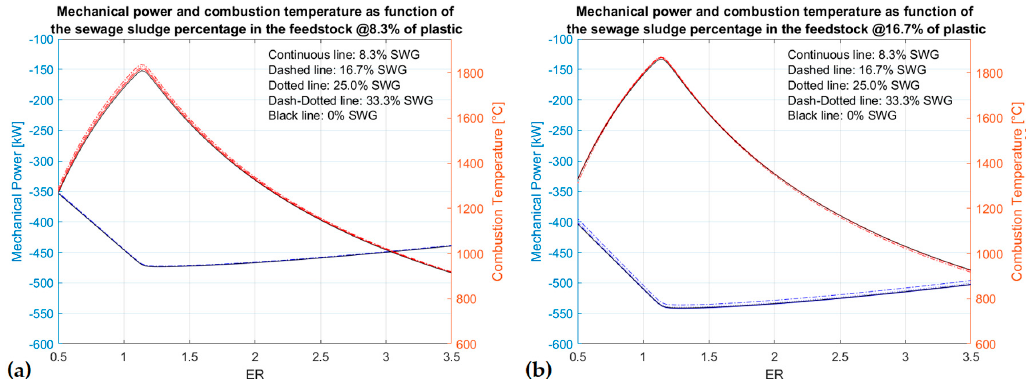
Figure 16. ( a ) Syngas and feedstock LHV as a function of plastic and sewage fraction; ( b ) cold gas efficiency as a function of plastic fraction and sewage fraction.